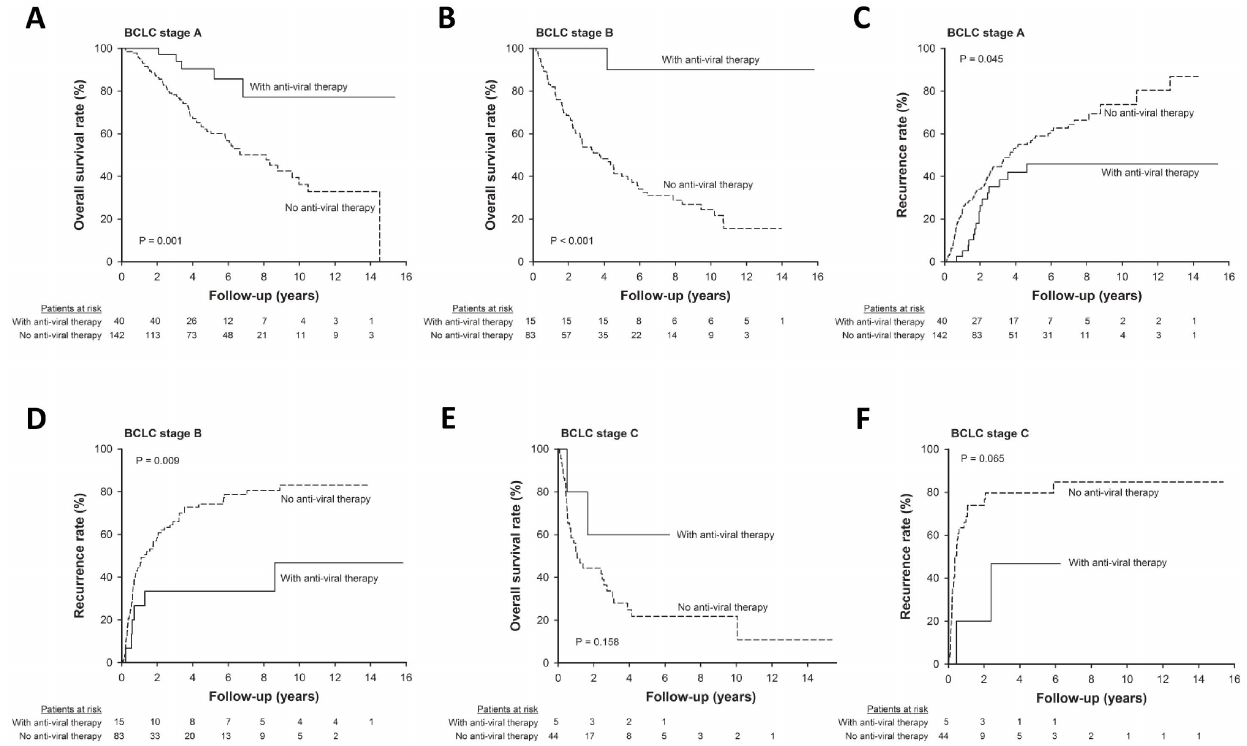
Figure 2. The effect of anti-viral therapy on post-operative prognosis stratified by tumor stage. Among patients with early stage HCC, those who received anti-viral therapy after resection had higher overall survival rate ( A , BCLC stage A, p =0.001; B , BCLC stage B, p , 0.001) and lower recurrence rate ( C , BCLC stage A, p =0.045; D , BCLC stage B, p =0.009) than their counterpart. For patients with BCLC stage C HCC, the overall survival rate were comparable between those with and without antiviral therapy ( E , p=0.158); but patients receiving anti-viral therapy after resection had a trend of lower recurrence rate than those who did not receive anti-viral therapy ( F , p=0.065). doi:10.1371/journal.pone.0066457.g002 PLOS ONE |